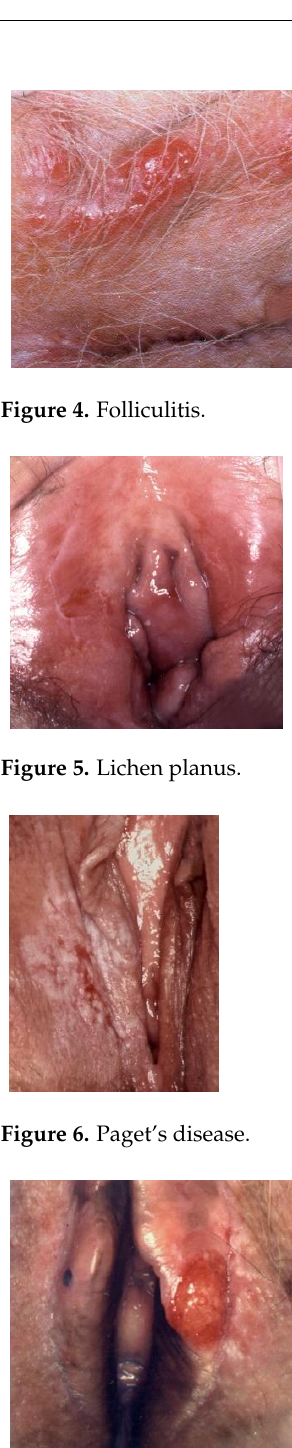
Figure 3. ( a ) Vulvar HSIL appearing as a red lesion; ( b ) after the application of Acetic acid.